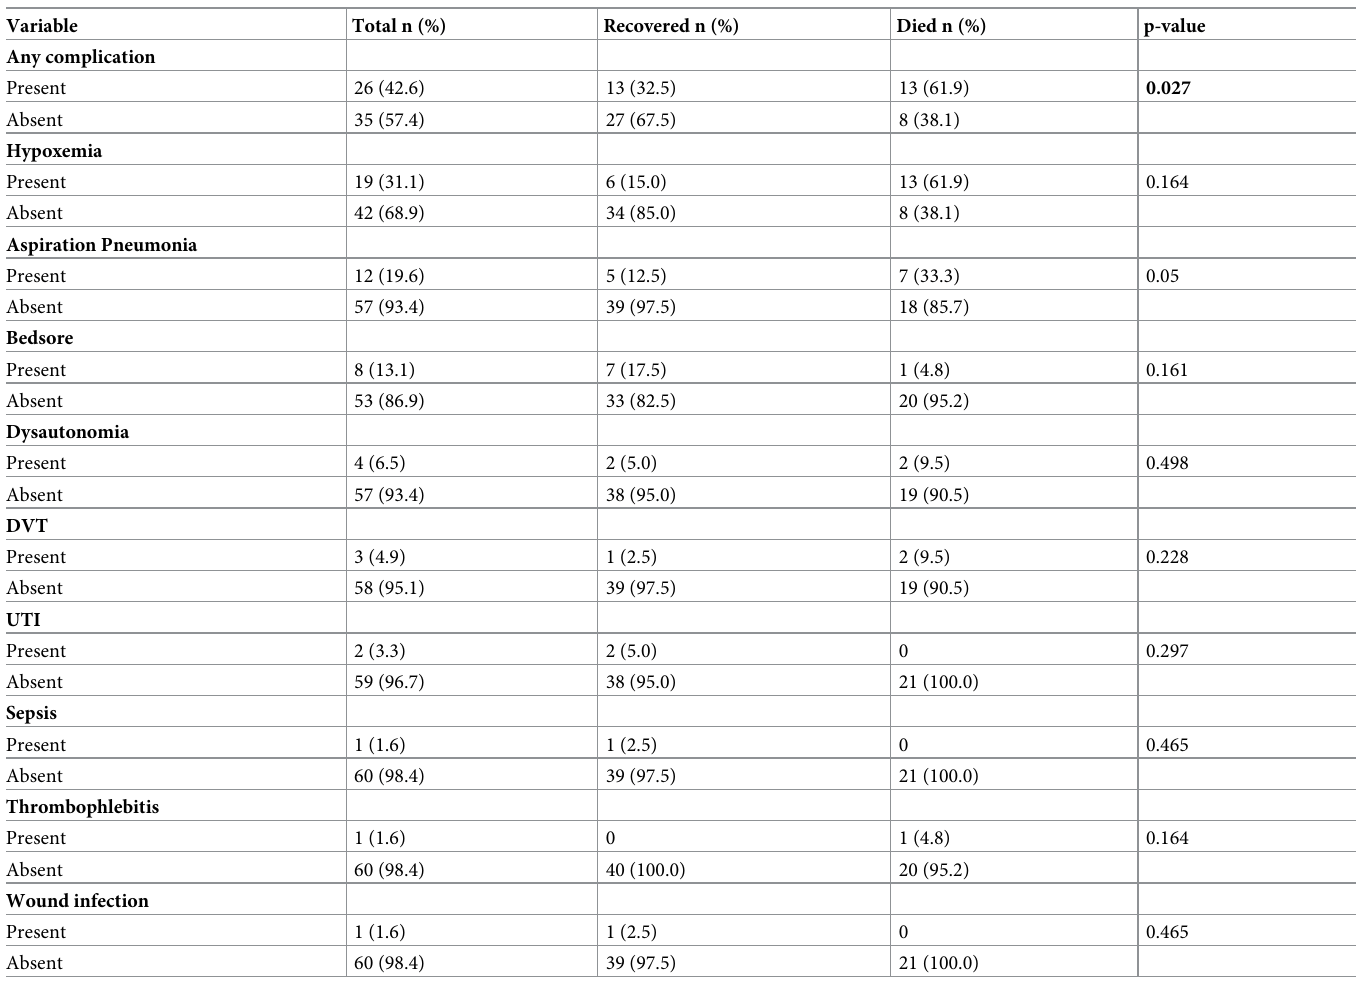
Table 5. List of complications among patients (n =